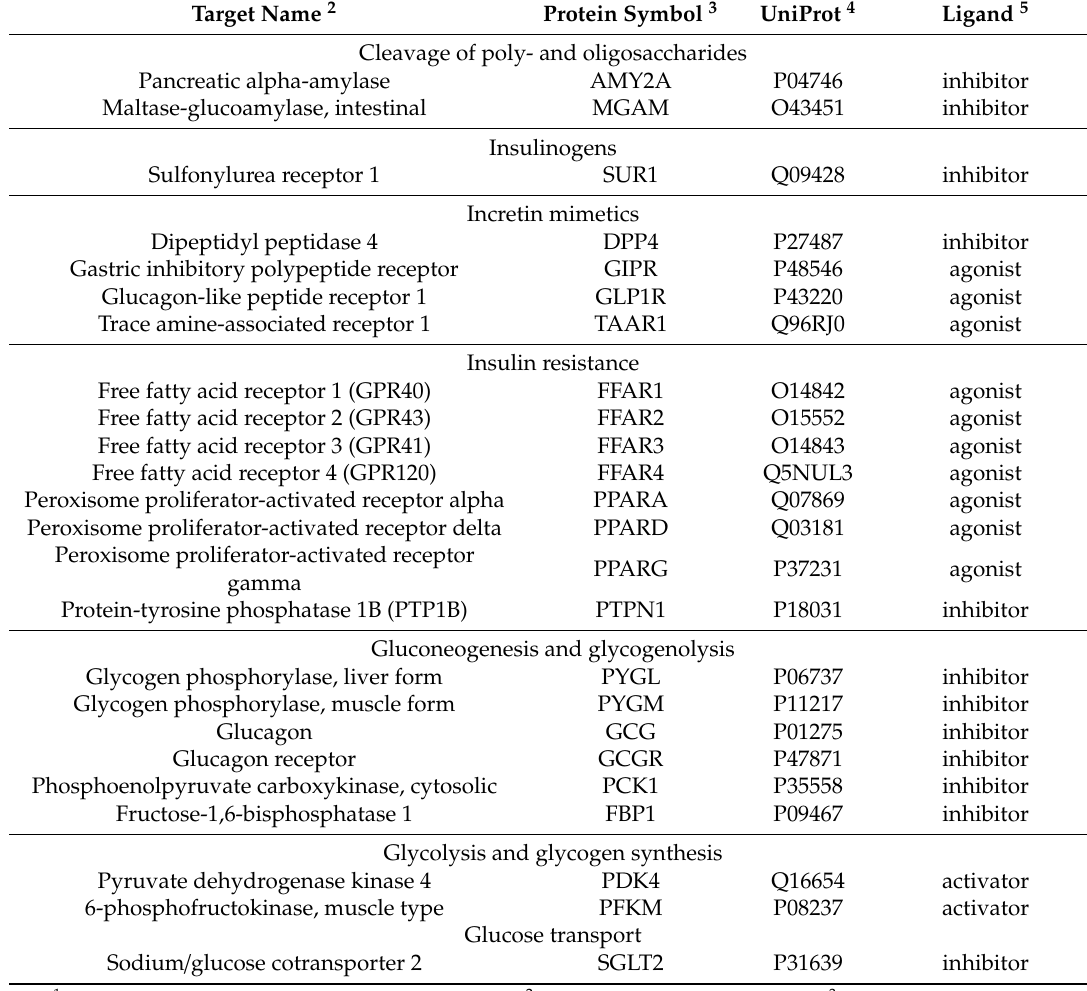
Table 1. Biotargets corresponding to possible hypoglycemic activities of the phenylpropanoic acid derivatives 1